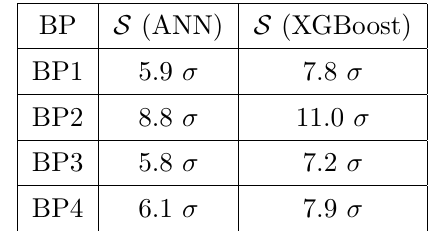
Table 8 . Signal signi(cid:12)cance for the benchmark points at 14 TeV with L = 3000 fb (cid:0) 1 for case I with ANN and